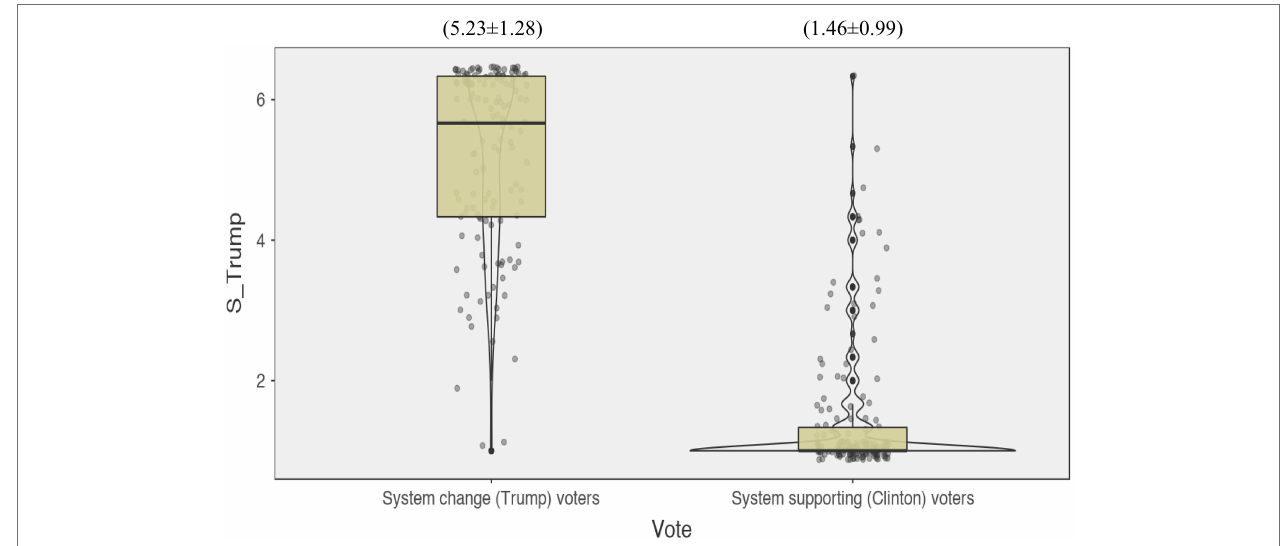
FIGURE 3 | Violin plots for the distribution of scores within the system supporting vs. system change voting groups for post-election support for the new Trump era. Numbers above the plots = (Mean ± SD ). S_Trump = support for Trump.